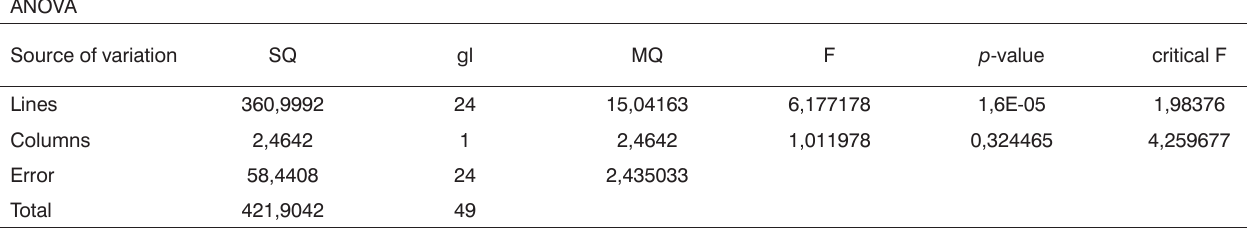
Key: SQ: sum of squares of deviations; gl: degrees of freedom for the distribution SQ = sum of squares; MQ = Squares mean, F = variance among groups, p = probability and critical F = critical factor Table 4. Analysis of variance for the condition of noise, comparing the right and left ears